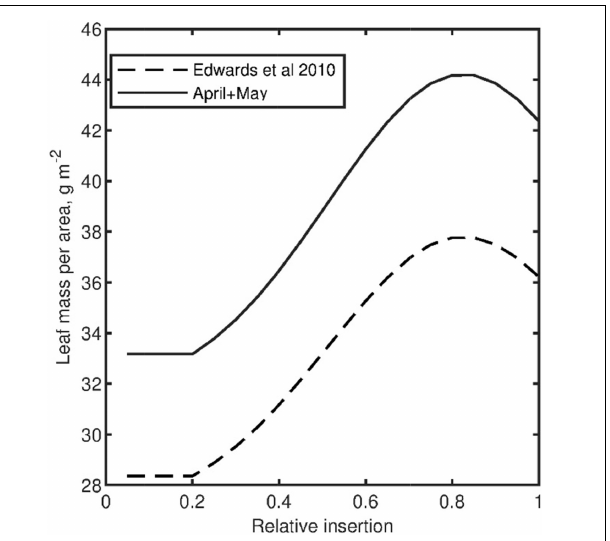
FIGURE 2 | Adopted vertical profile function of leaf mass per area (LMA) (without starch) during the tomato experiment based on LMA measurements of bottom leaves (relative insertion = 0) and an empirical equation form parameterized from Edwards et al.